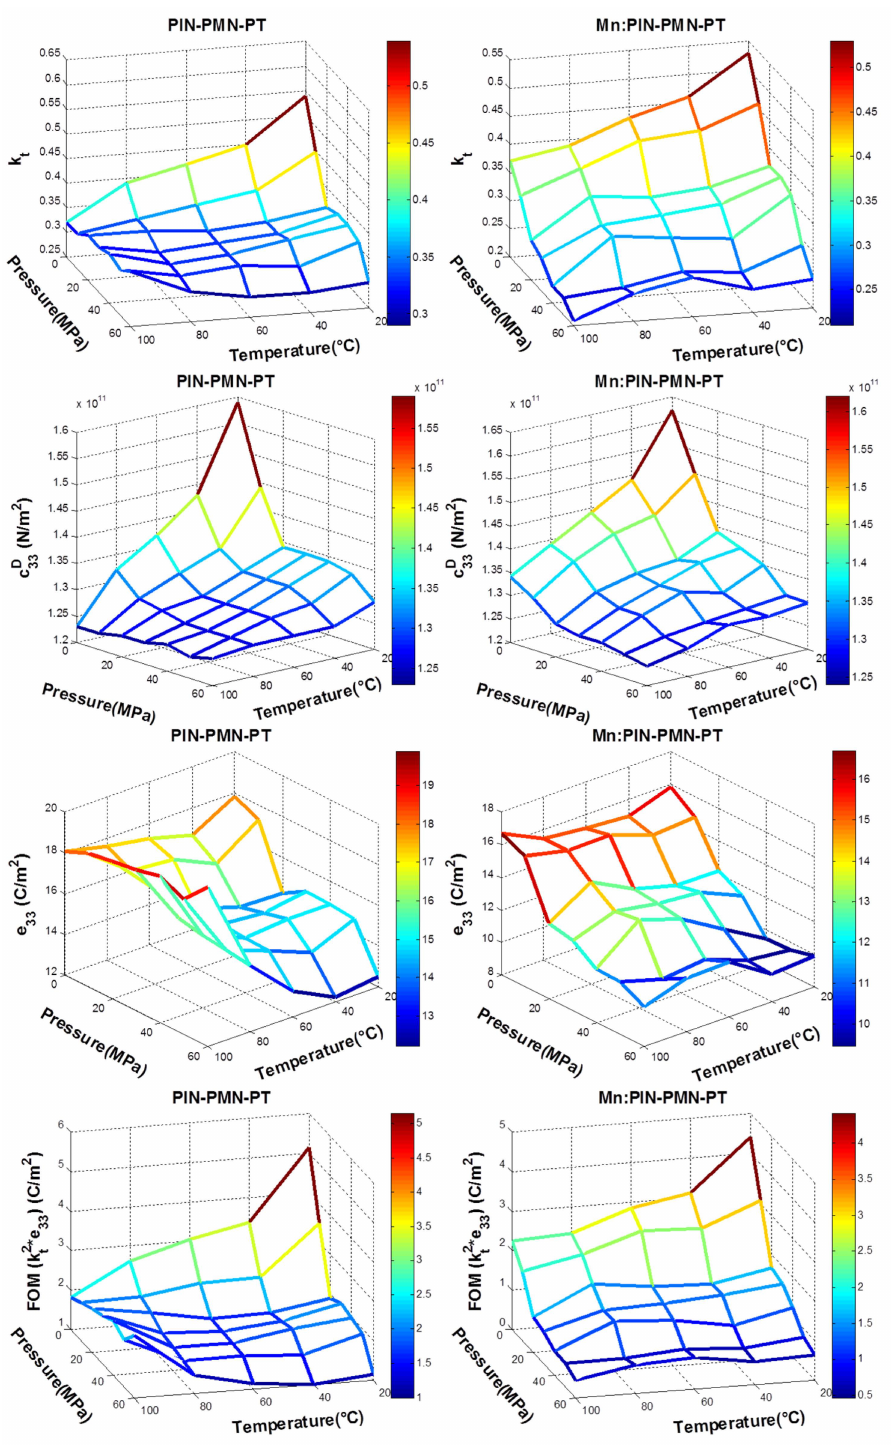
Figure 12. A summary of the variation of key parameters of PIN-PMN-PT and Mn:PIN-PMN-PT with varying temperature and pressure on ε S r 33 , k t , c D 33 , e 33 and one figure of merit ( k t 2 e 33